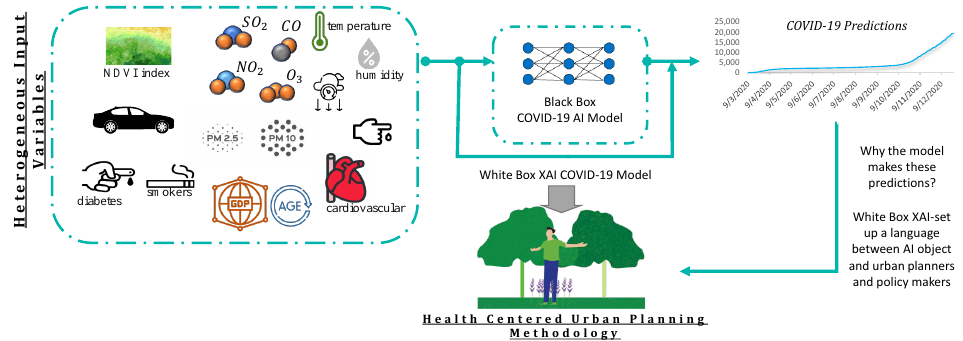
Figure 1. The proposed concept in spatial epidemiology using explainable AI and remote sensing. Explainable AI is the “language” to translate the results of the AI model, in an easy to understand and interpretable way, to the urban planners, to support them in the decision-making process for health-centered urban planning